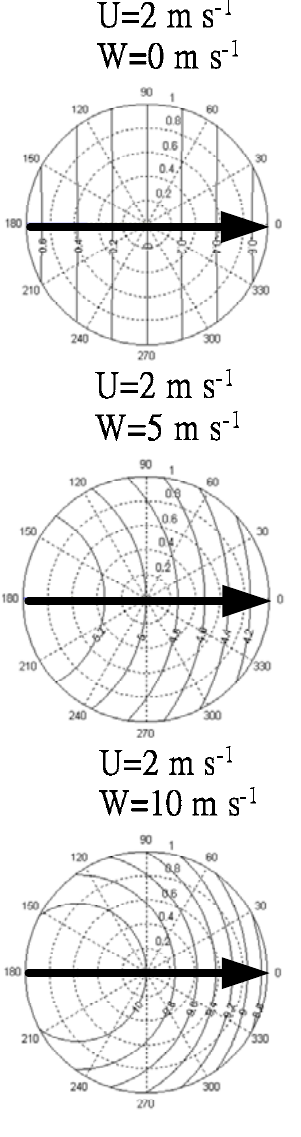
Fig. 5. Comparison of contours of radial velocity for the different ratios of vertical wind velocity to horizontal wind velocity, in which a bold arrow in each panel shows the horizontal wind